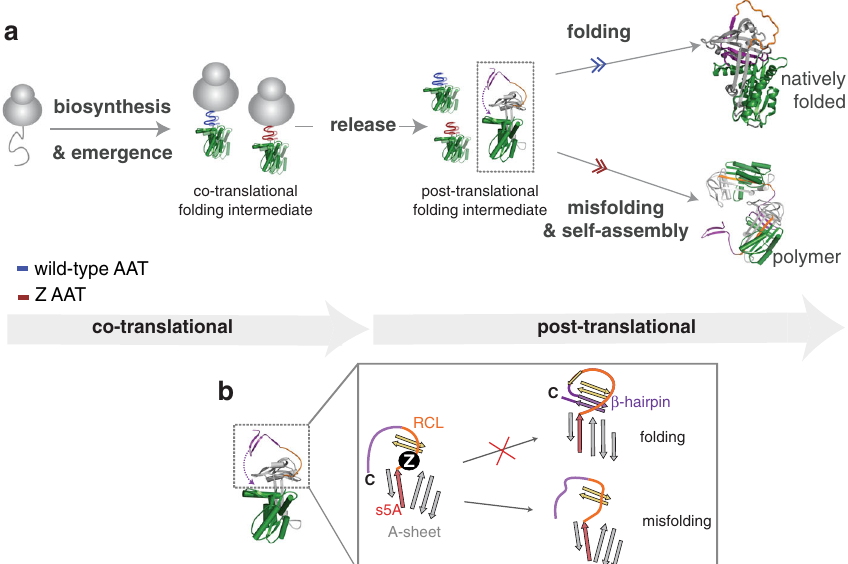
Fig. 8 Co-translational and post-translational folding and misfolding AAT. a A folding and misfolding model for AAT during biosynthesis. Highlighted in green is the 1 – 191 fragment that forms co-translational structure on the ribosome. b A schematic showing how Z ’ s kinetic folding defect, which begins developing co-translationally, guides post-translational folding outcomes. Shown is a magni fi ed view of the A-sheet/RCL region in the post-translational intermediate: A-sheet (grey, and strand 5A (s5A) in red), B-sheet (gold), reactive centre loop (RCL), orange, β -hairpin (purple). The insertion of the fi nal 35 C-terminal residues to form a β -hairpin in AAT ’ s core and complete the native fold, is a key component of the folding/misfolding